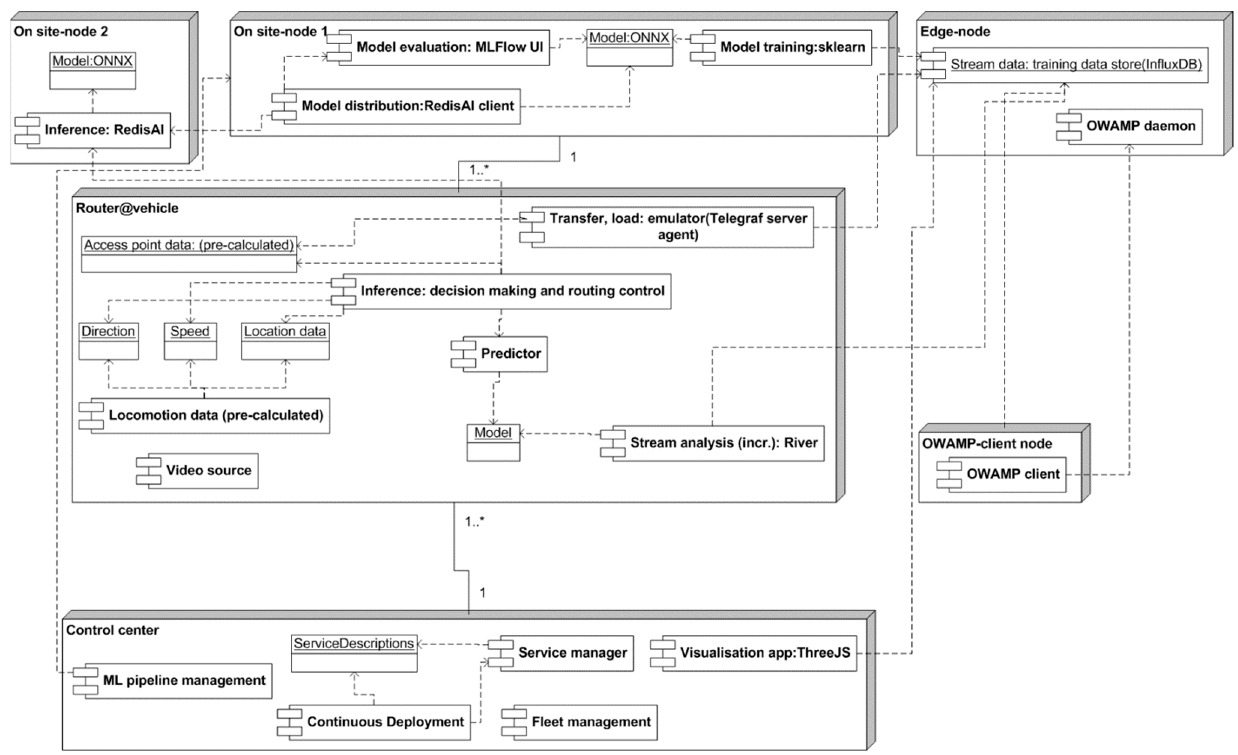
Figure 4. System view of the emulator. The view has been illustrated as a Unified Modeling Language (UML) deployment diagram.